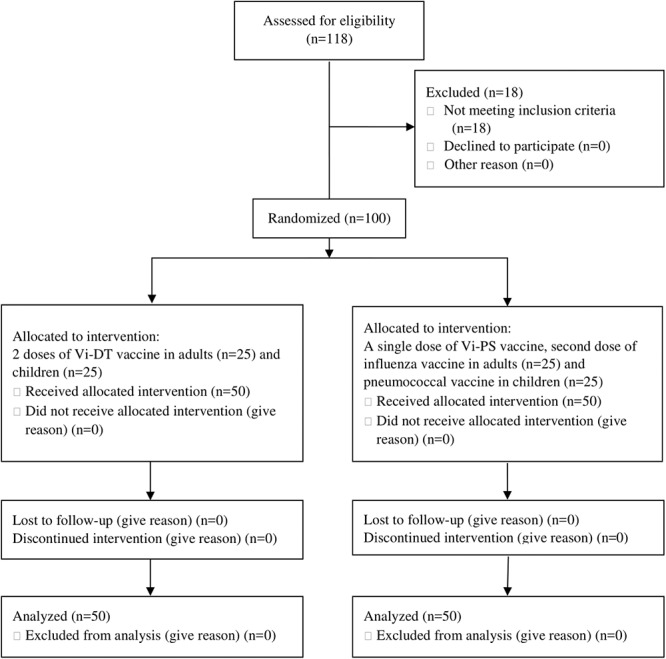
Consort diagram.